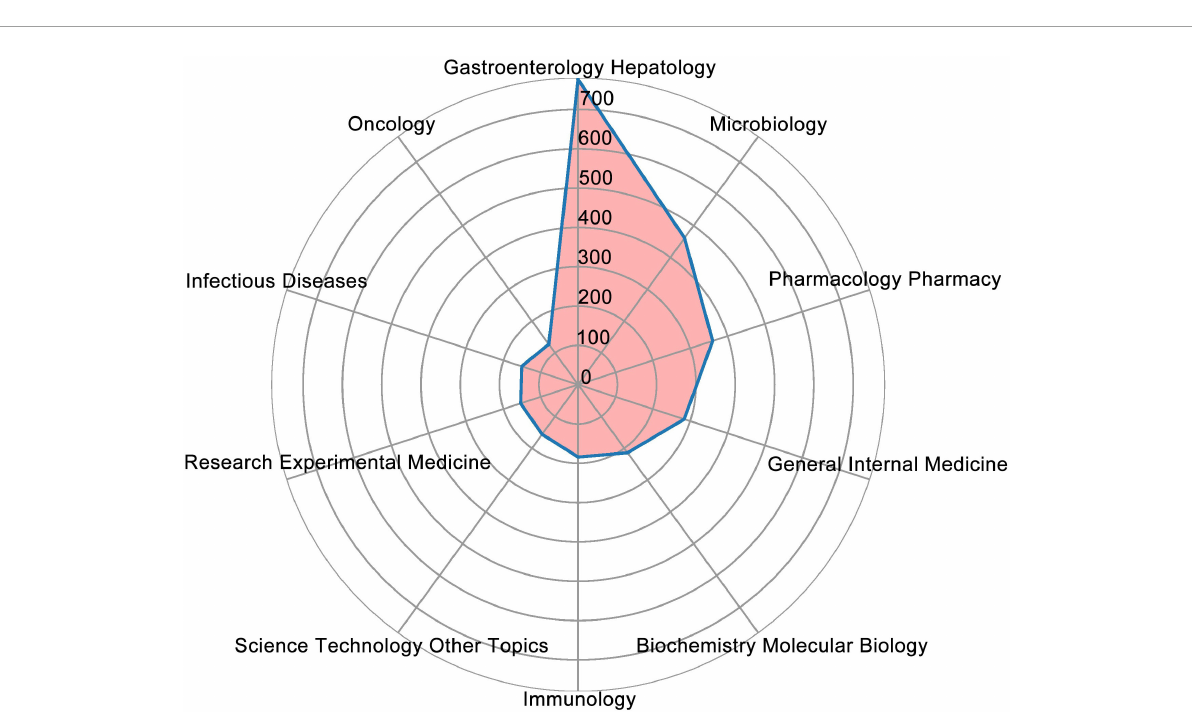
FIGURE6 Top 10 research directions for the journals of Helicobacter pylori -related gastric ulcer (GU).